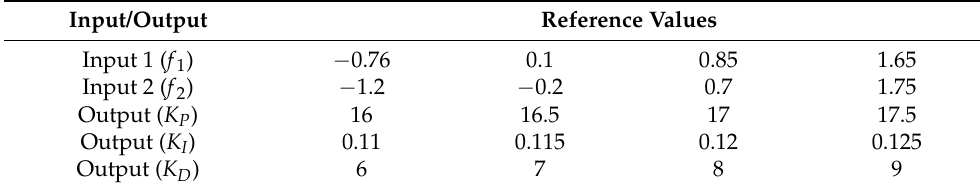
Table 5. Initial reference values of inputs and outputs.